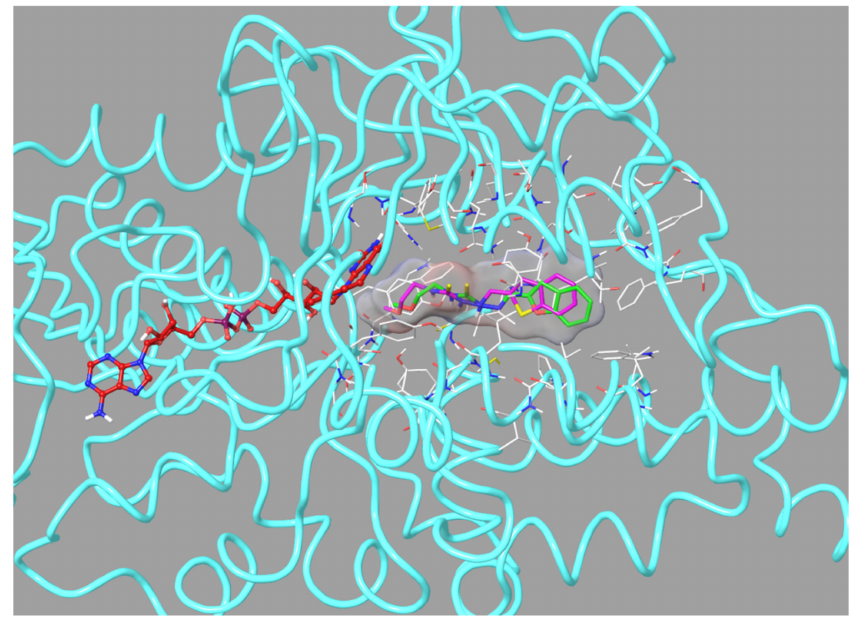
Figure 6. The superimposition pose of compounds 2b and 2h in the active region of hMAO-B (PDB ID: 2V5Z). The important residues in the active site and compounds 2b and 2h are presented by tube model and colored with white, green, and pink,